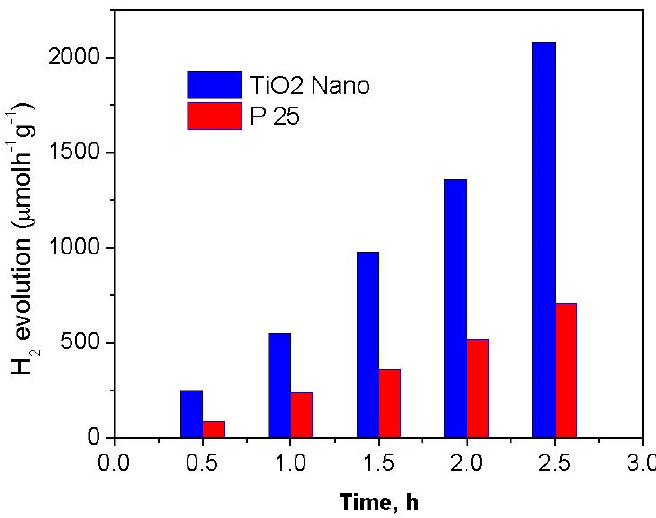
Figure 7. Hydrogen generation of commercial (P-25) and TiO 2 nanoparticles. Table 1. Comparison of the hydrogen evolution of TiO 2 nanoparticles synthesized by hydrothermal method using various functionalized ionic liquid.